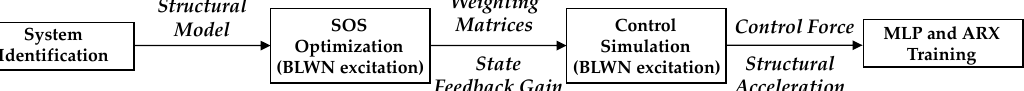
Figure 13. Flowchart of the design and training procedure for the experimental validation. BLWN: band-limited white noise.